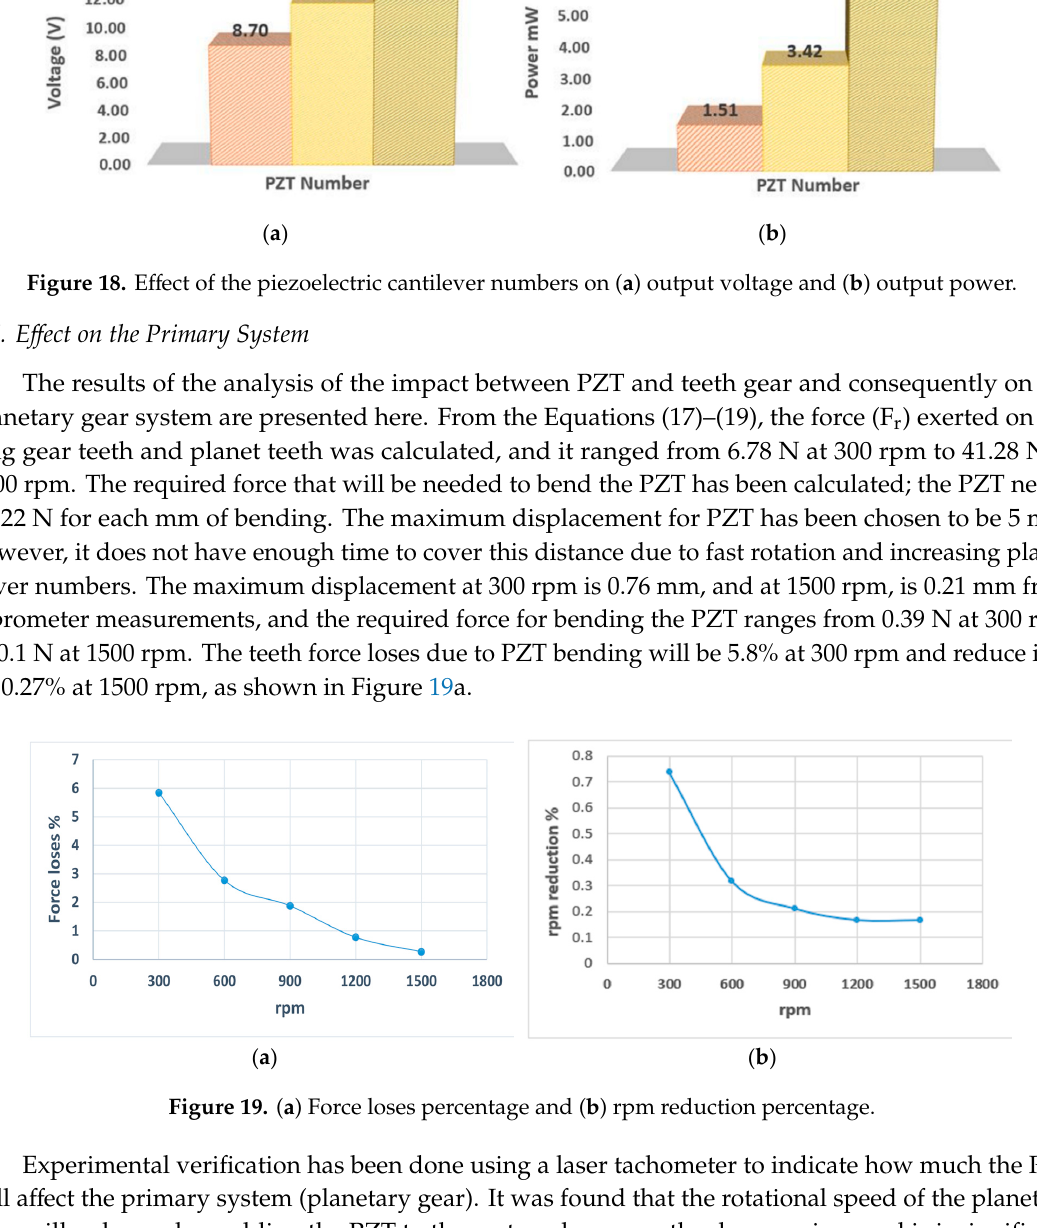
Figure 19. ( a ) Force loses percentage and ( b ) rpm reduction percentage.